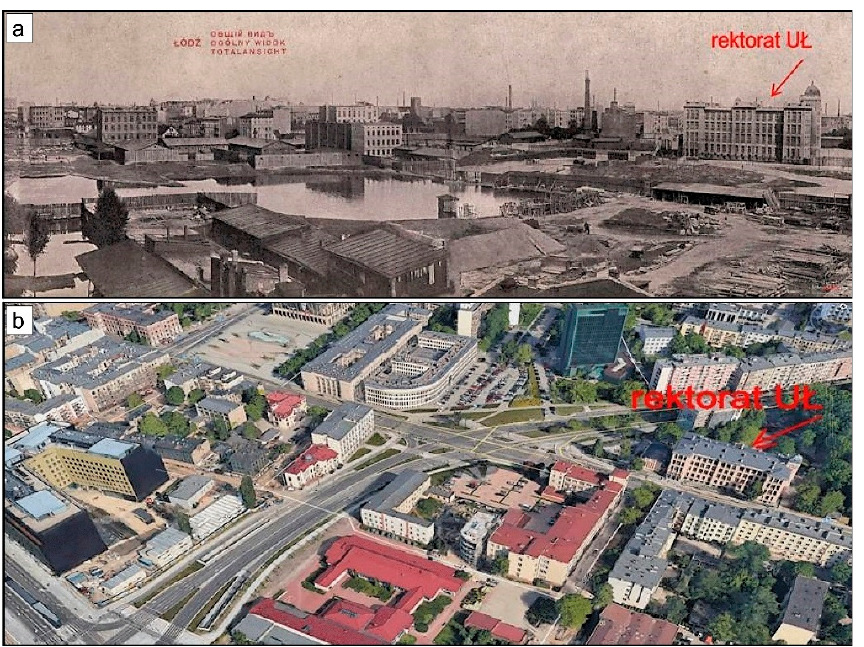
Figure 11. The pond at the mineral extraction site juxtaposed with today’s image of the area. (The location). Source: ( a ) fotopolska.eu, 1910–1914, ( b ) Goggle Earth 2021.